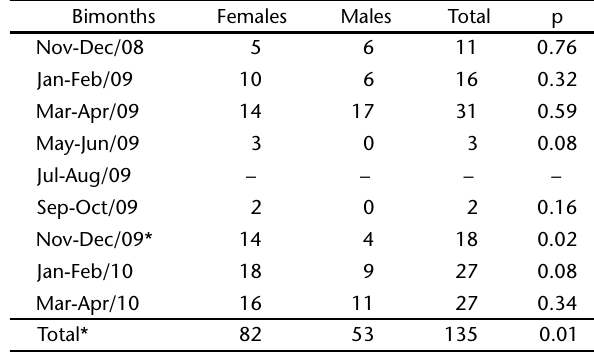
Table I. Sex ratio of Trachelyopterus lucenai specimens captured in Itapeva, Quadros and Malvas lagoons in the Tramandaí River